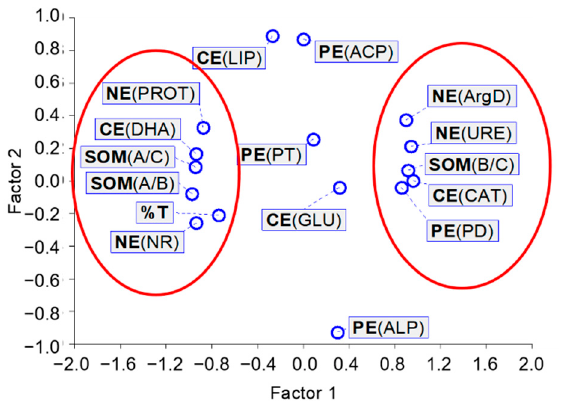
Figure 6. Characteristics of the exploratory factor analysis; CE—enzymes involved in carbon cycle: